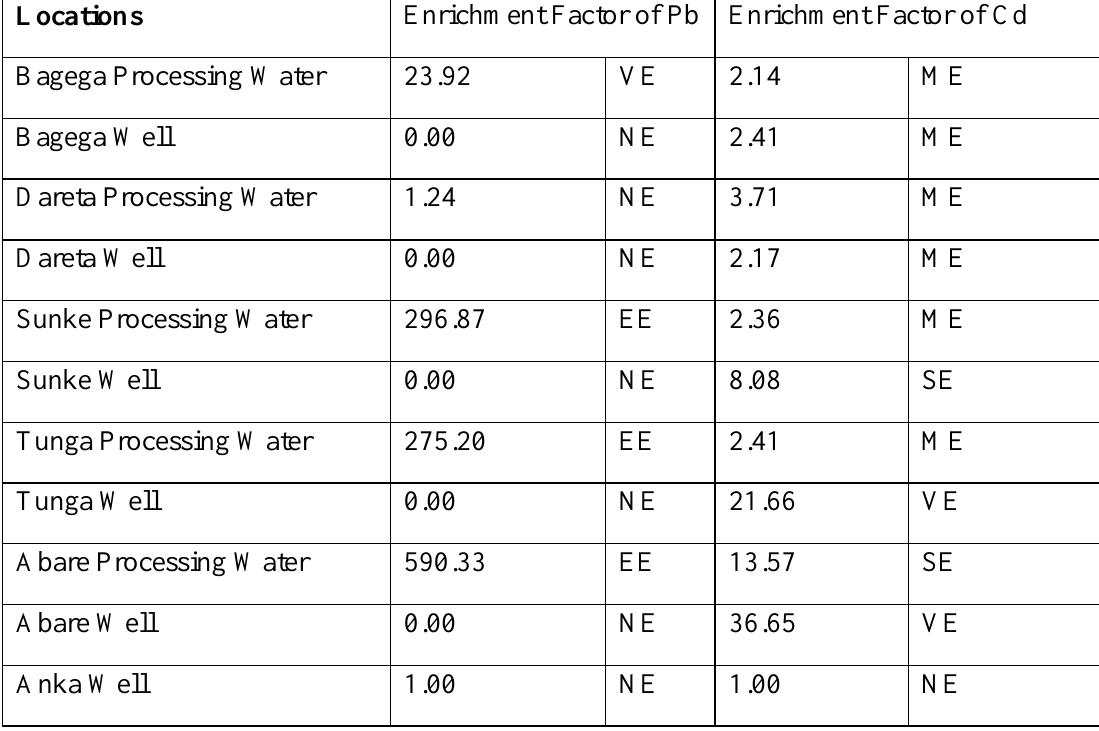
Table 2. Enrichment factor of the heavy metals in water from all the study locations in Anka Local Government, Zamfara State Locations